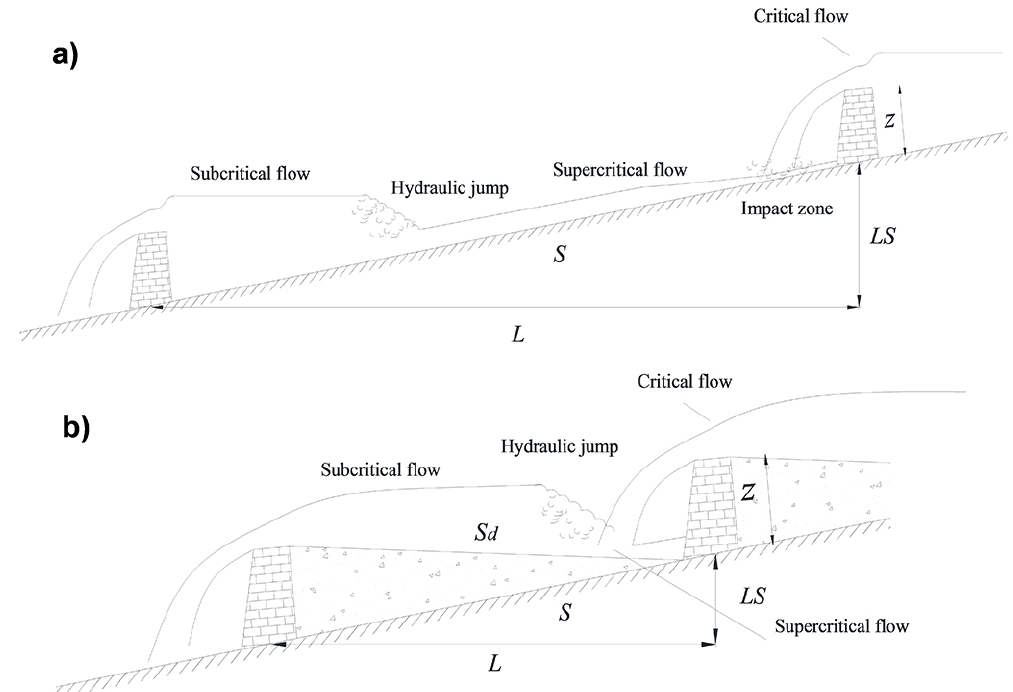
Fig. 1. Sketch of the main hydraulic features and geometric variables after check dam construction, (a) initial conditions; (b) dam-filling situation. L : spacing between adjacent check dams; LS: difference in elevation between check dams; S : Gully slope; S d : deposition slope; z : effective height of the check